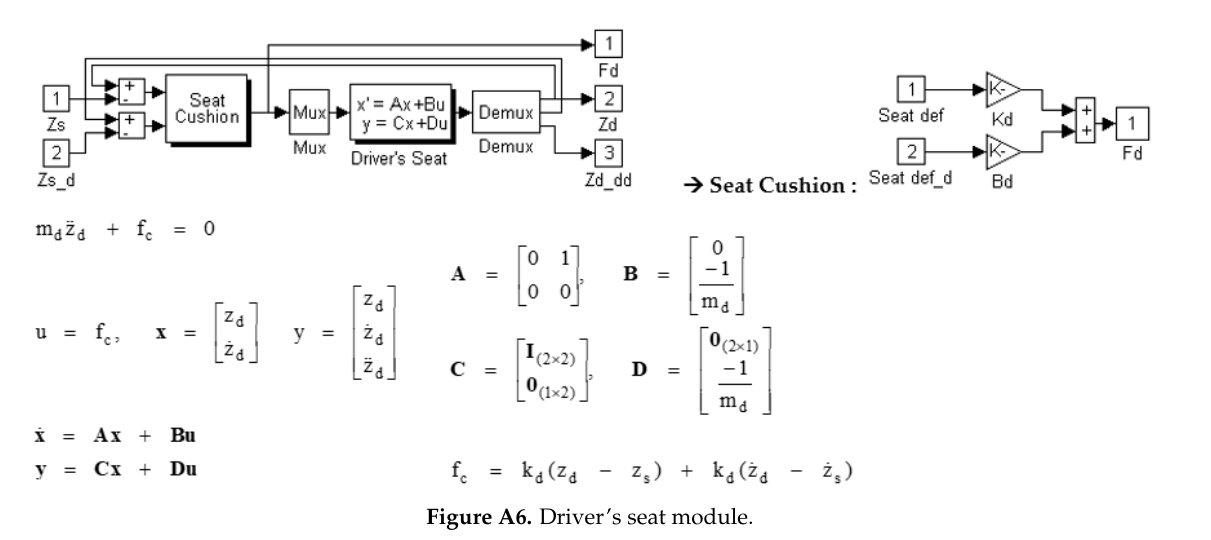
Figure A6. Driver’s seat module.